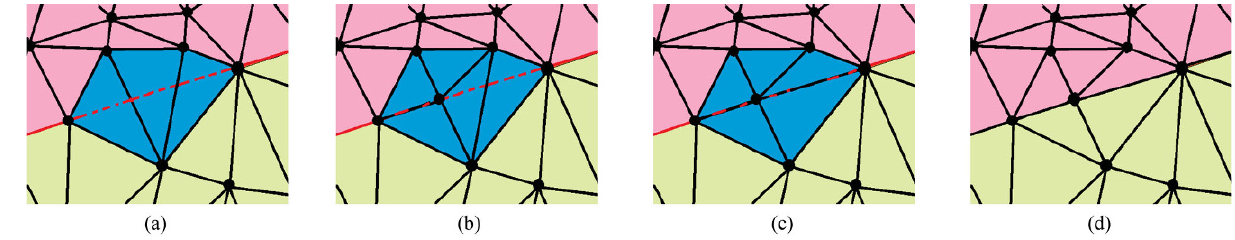
Fig. 4 Edge splitting (Case I). (a) Before splitting. (b) After splitting. (c) Edge flip. (d) Face